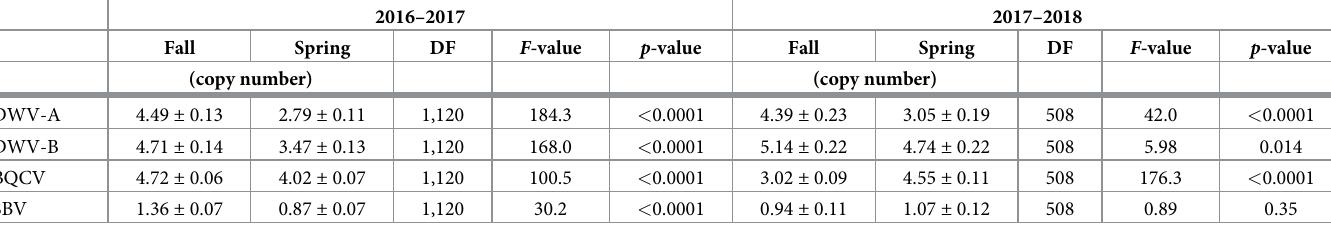
Table 3. Viral seasonal variance during experimental year 1 and